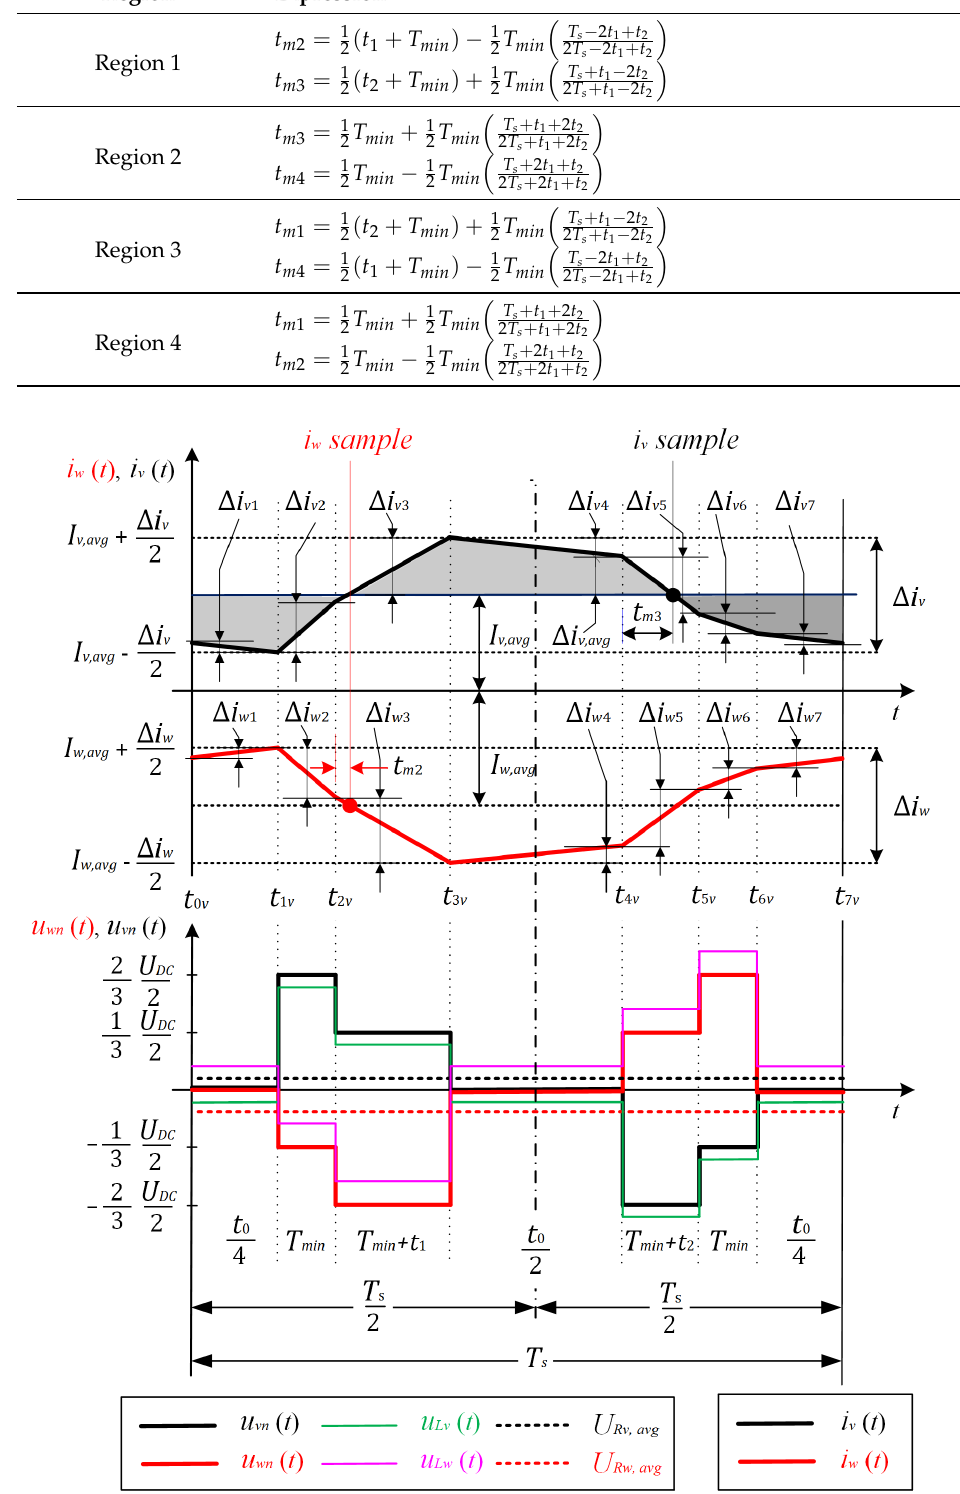
Figure 8. Characteristic voltages and phase currents for Region